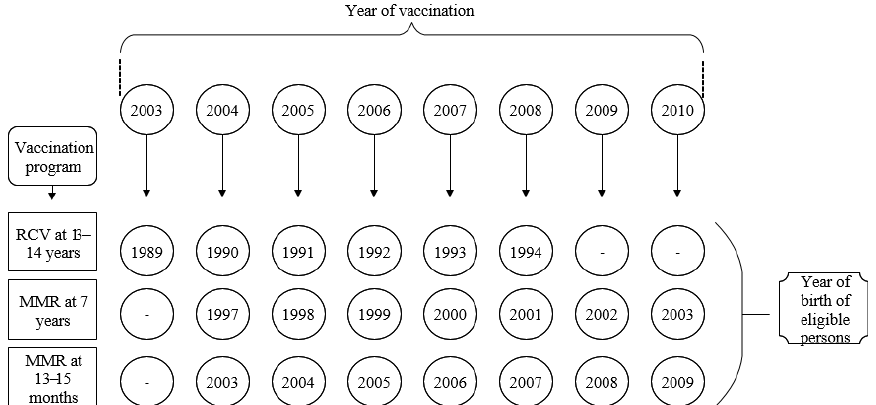
Figure 1. Romanian rubella national vaccination schedule (2003–2010). RCV = Monovalent Rubella contained vaccine; MMR = Measles-Mumps-Rubella vaccine.